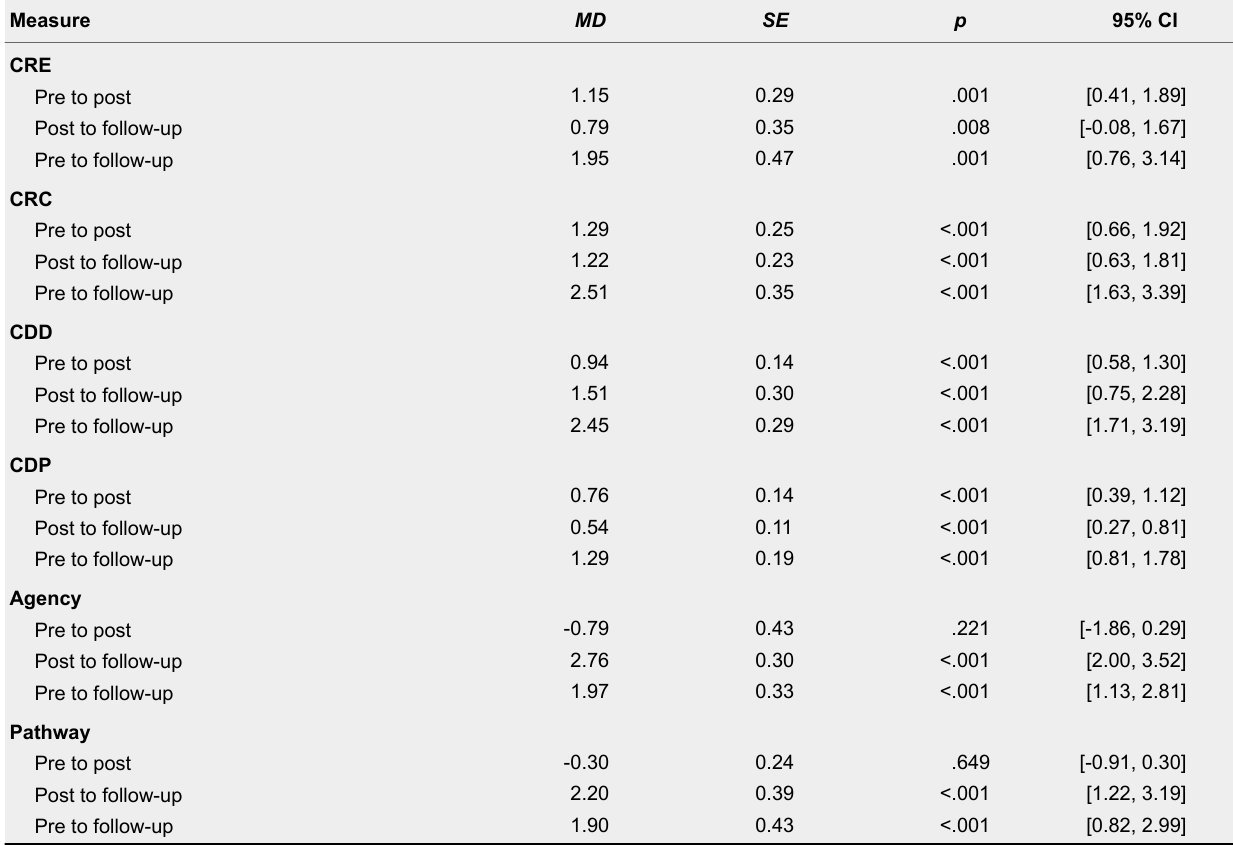
Pairwise Comparisons From Pre to Post, Post to Follow-Up, and Pre to Follow-Up Assessments on the Outcome Measures in Training Participants (N = 33)